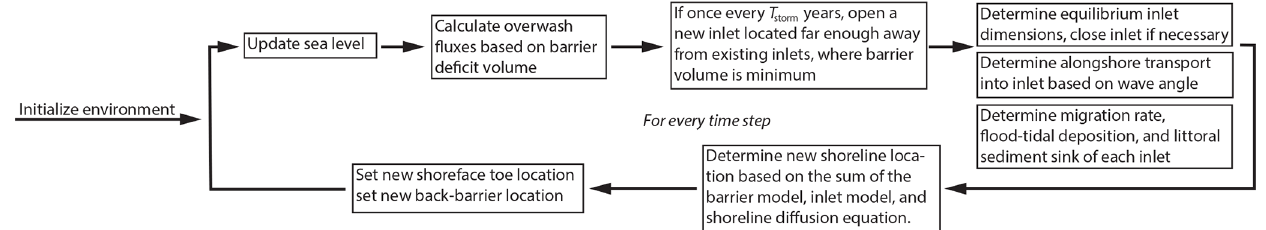
Figure 2. Model structure showing the time loop in which the model updates SLR and calculates resulting barrier island